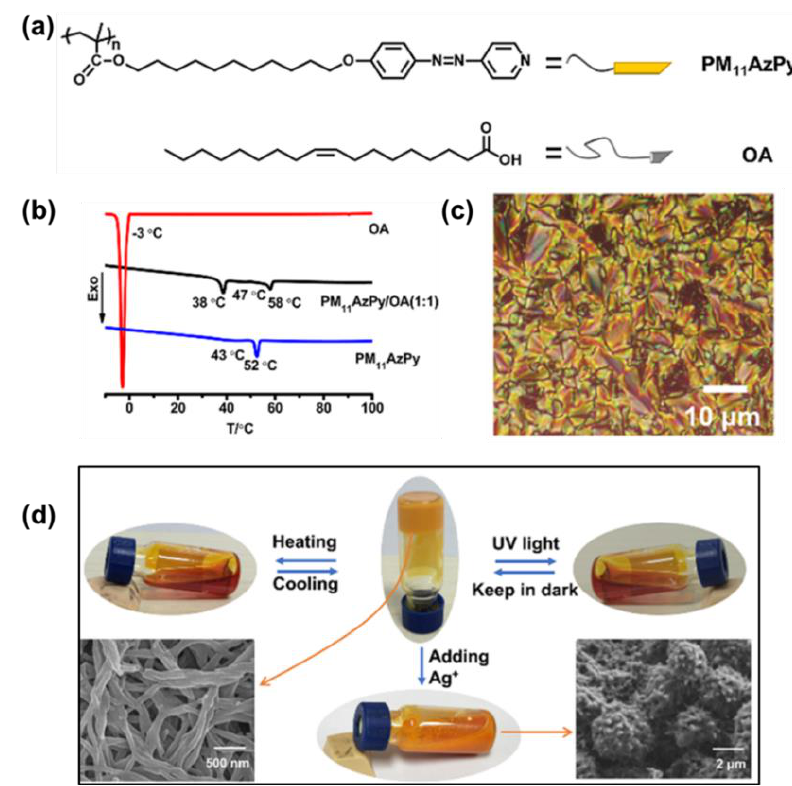
Figure 10. ( a ) Chemical structures of the azopyridine-containing polymer (PM 11 AzPy) and oleic acid (OA); ( b ) DSC curves (second cooling scan) of OA, PM 11 AzPy, and PM 11 AzPy−OA (1:1); ( c ) One POM image of the compound PM 11 AzPy−OA (1:1) annealed at 46 °C, scale bar: 10 μm; ( d ) Photos of the organogel in response to heating, UV light, and adding Ag + (inset SEM image: PM 11 AzPy−OA (1:20) xerogel and precipitates from the organogel after adding Ag + ). Reprinted with permission from [68]. Copyright 2019, American Chemical Society.